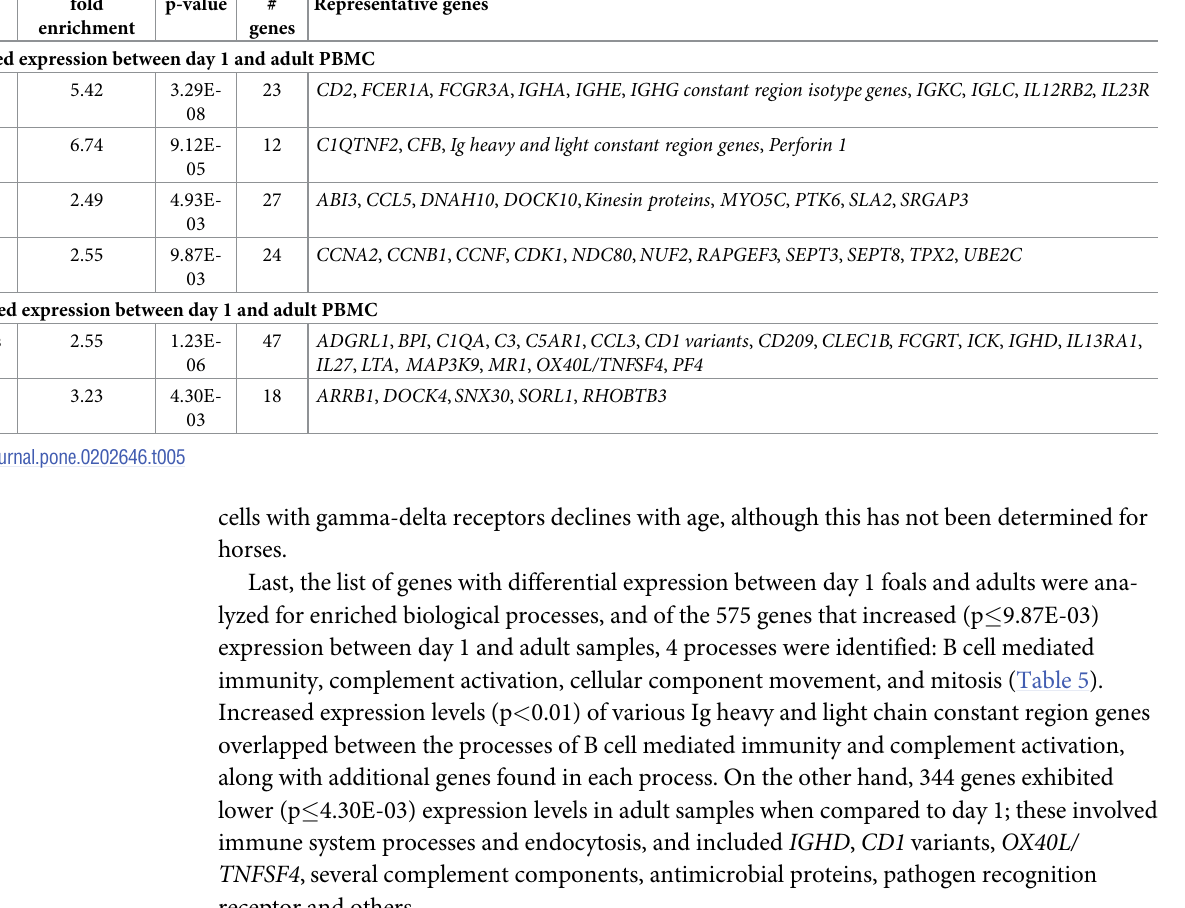
Table 5. Gene enrichment analysis of differentially-expressed genes between day 1 foal and adult horse samples. Biological